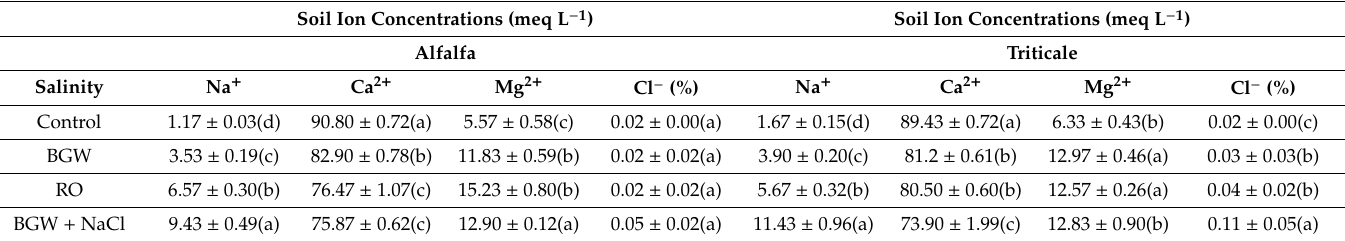
Table 4. E ff ect of irrigation water salinity on the presence of ions in the leachate of alfalfa and triticale after the conclusion of two runs conducted in sand soils. Means within species sharing the same letter are not significant at α ≤ 0.05. Each observation is the mean ± SEs of three replications. The ECs of the saline treatments